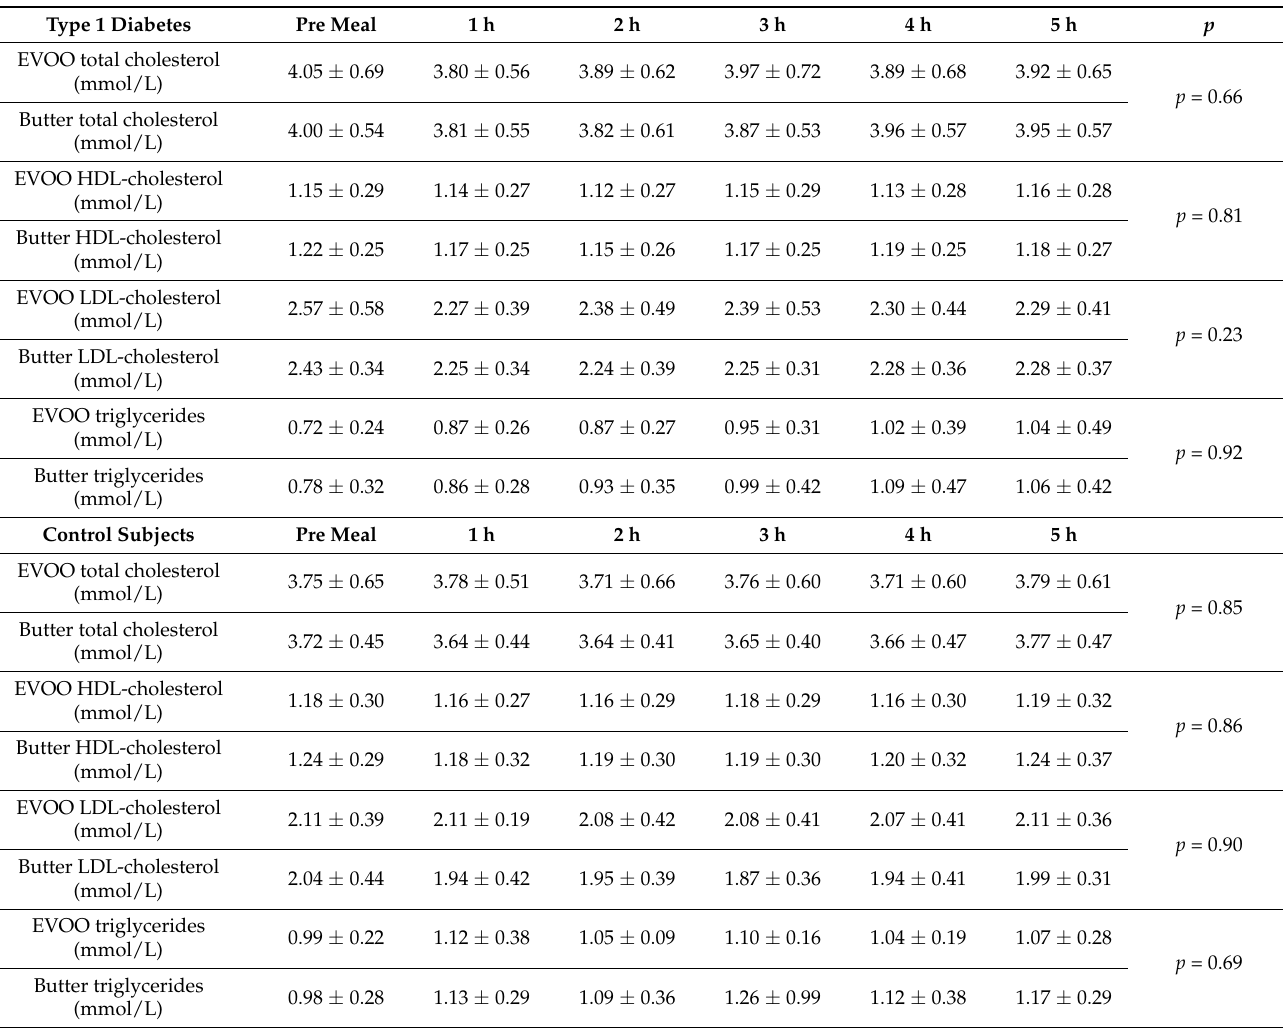
Table 3. Lipids at pre-meal and after 1 h, 2 h, 3 h, 4 h, 5 h, post-meal in subjects with type 1 diabetes and control subjects. Type 1